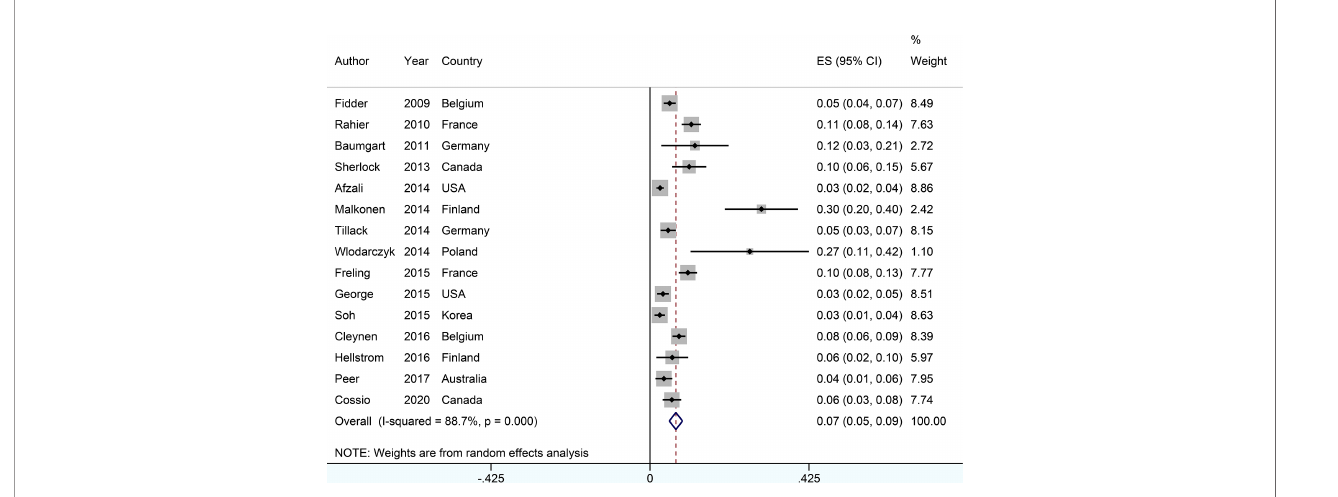
FIGURE 2 | Forest plots of incidence of psoriasiform lesions associated with anti-tumor necrosis factor therapy in in fl ammatory bowel disease